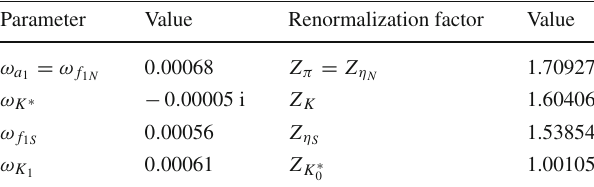
Table 1 Parameters and wave-function renormalization constants Parameter Value Renormalization